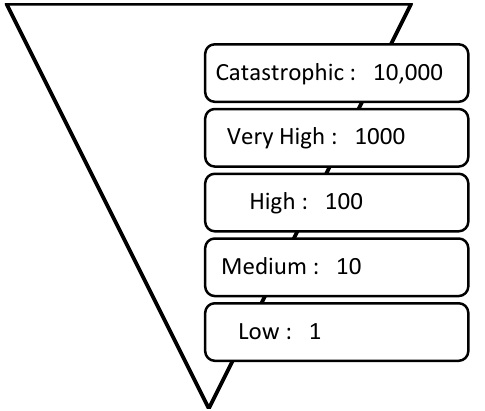
Figure 2. Ratio of health metrics across health consequence